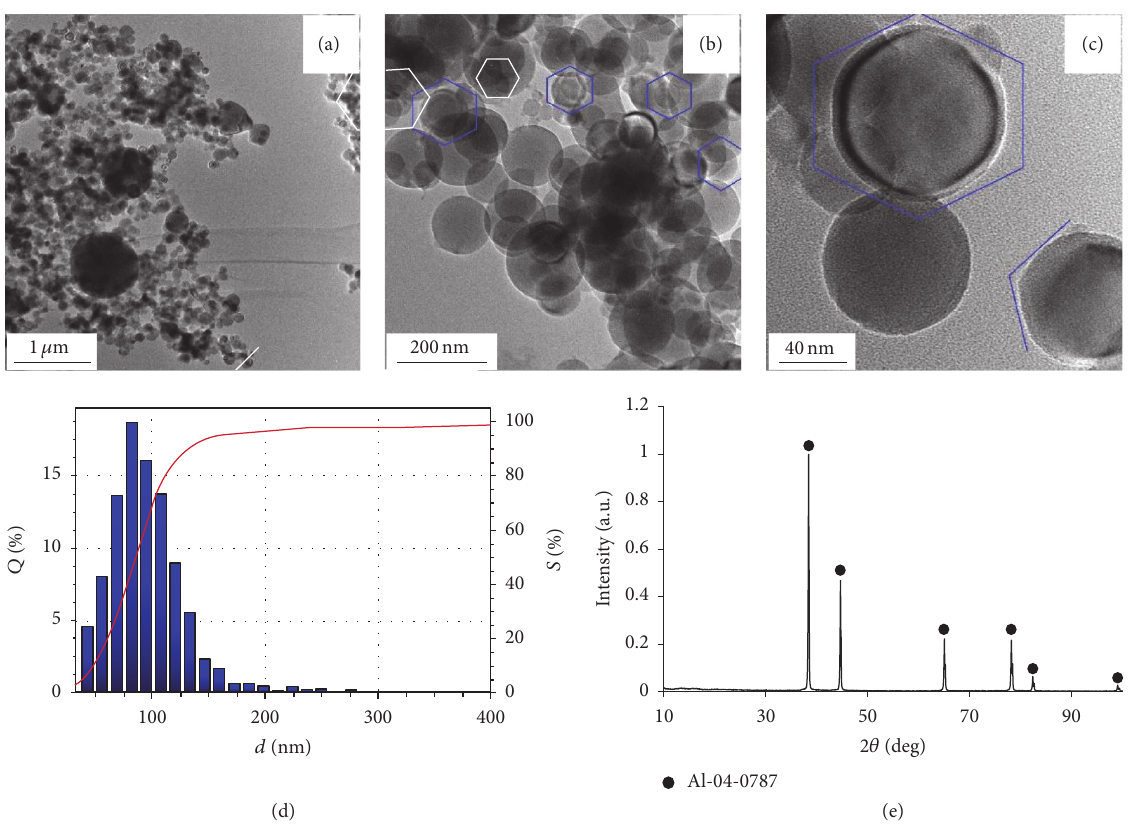
Figure 3: Microphotographs (a, b, c ), histogram of the particle size distribution (d), and XRD pattern (e): sample Al-5: 𝑎 𝑛 = 130 nm; 𝑎 𝑆 = = 180 nm; 𝑘 = 0.7 . 150 nm; 𝑎 𝑚